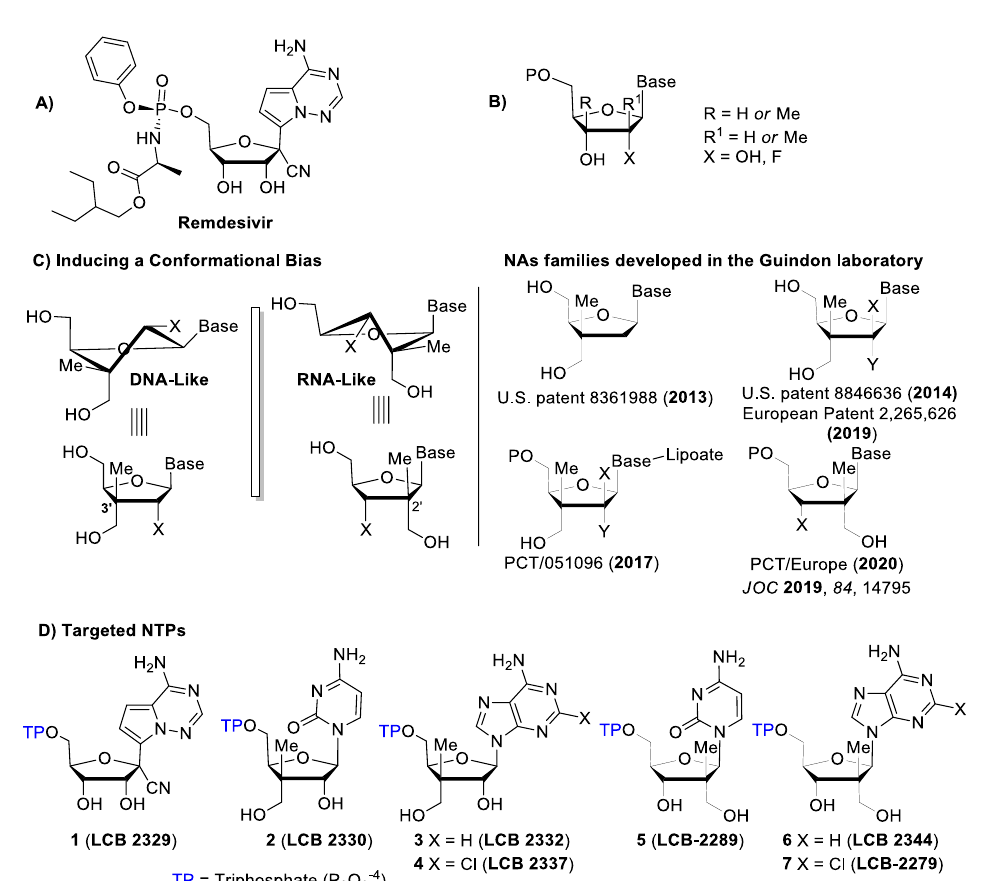
Figure 1. Nucleoside analogues containing a quaternary stereocenter at C 2′ or C 3′ . A: Remdesivir Prodrug; B: Reported nucleotides having different substituents at C2′ or C3′ ; C: Induced conformations of novel nucleoside analogues; D: Targeted novel NTPs.